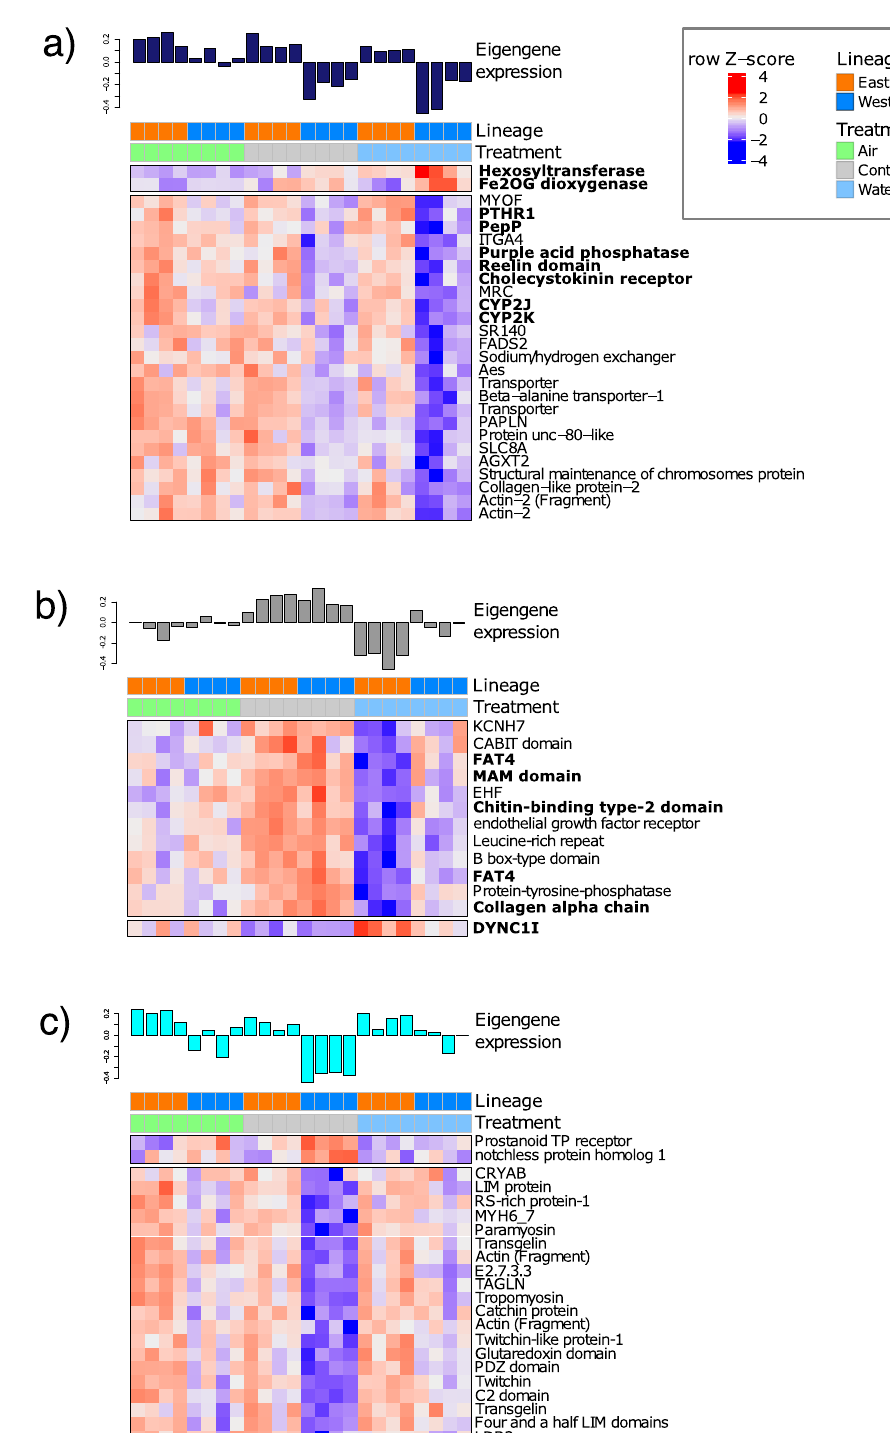
Figure 8. Gene expression heatmaps of annotated transcripts (MM > 0.6, GS > 0.6) in three WGCNA modules. The per sample eigengene expression is shown above each heatmap showing the correlation with WATER samples from ( a ) the western and ( b ) eastern lineages, and with ( c ) CONTROL from the western lineage. Heatmap colours are scaled by row Z-score; blue = downregulated, red = upregulated genes. Genes shown in bold are discussed in the text. Coloured bars at the head of each heatmap indicate the experimental treatment and lineage for each sample as indicated in the legend. Heatmap was produced using R/Bioconductor package ComplexHeatMaps 42 (http:// bioco nduct or. org/ packa ges/ relea se/ bioc/ html/ Compl exHea tmap.